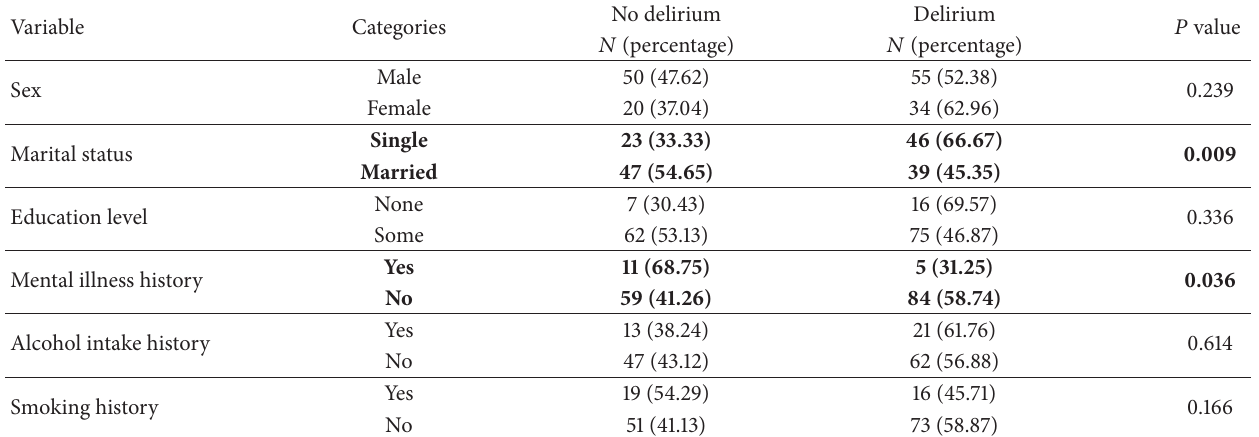
Table 1: Baseline demographic characteristics.